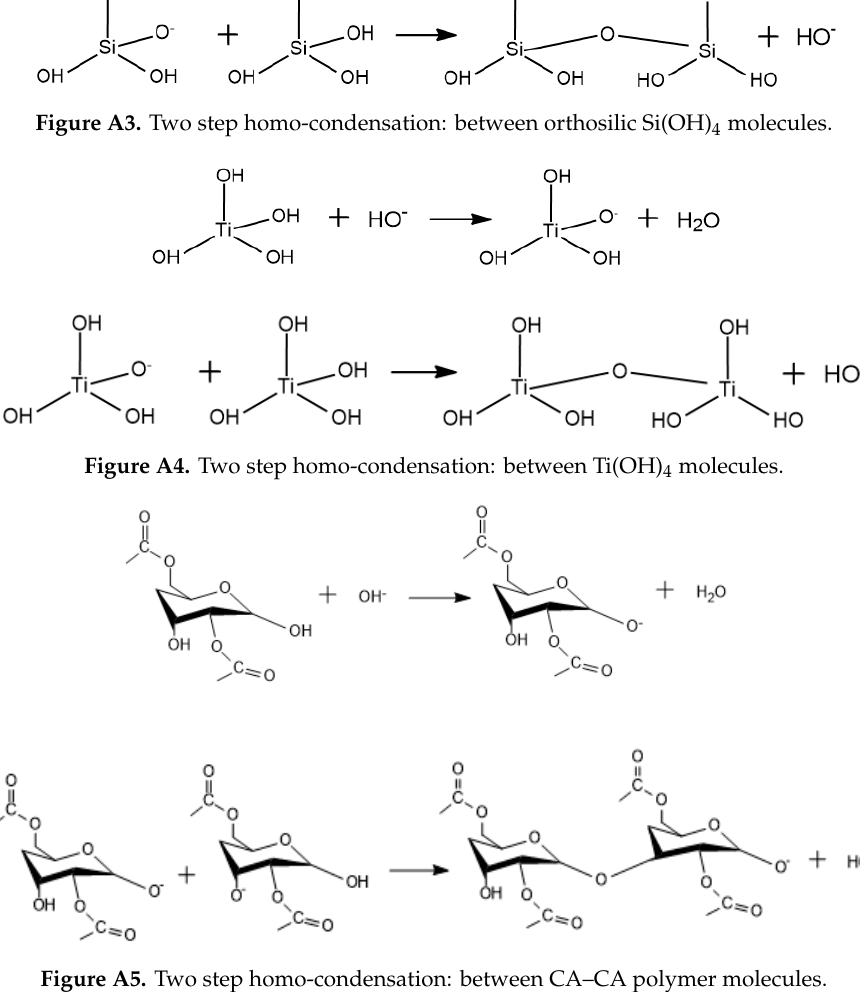
Figure A6. Hetero-condensation between Si(OH) 4 and CA polymer molecules.